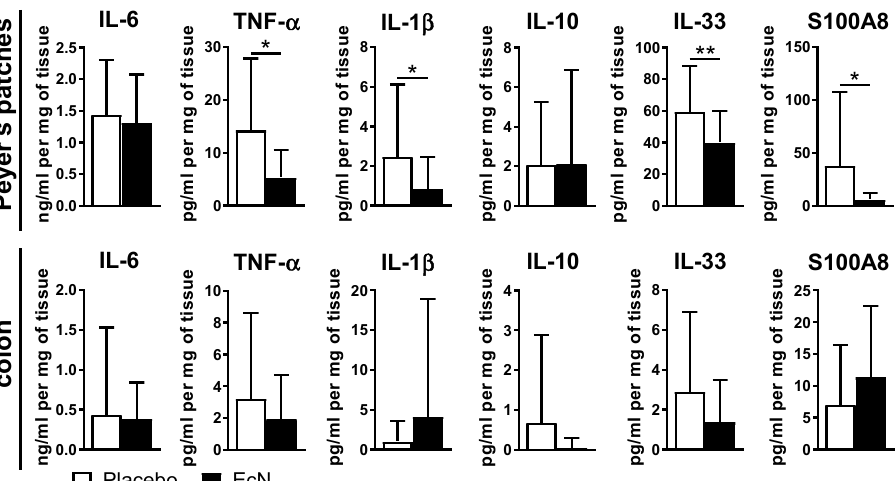
Figure 6. Analysis of proteins in supernatants of cultured cells from Peyer’s patches and colon tissue at day 28 post-induction. Live oral EcN decreased the production of several pro-inflammatory cytokines in Peyer’s patches but not in the colon. Data are pooled from 5 independent experiments ( n = 25 per group in total) and differences were quantified by unpaired Mann–Whitney test; * p < 0.05 ** p < 0.01.